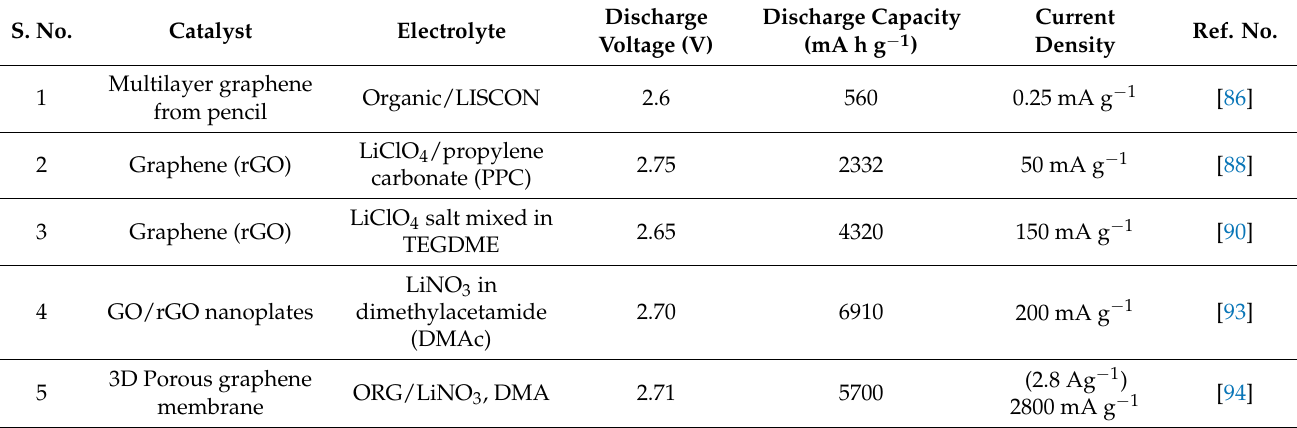
Table 2. Comparison of the cell performances of various nonmetal-doped graphene